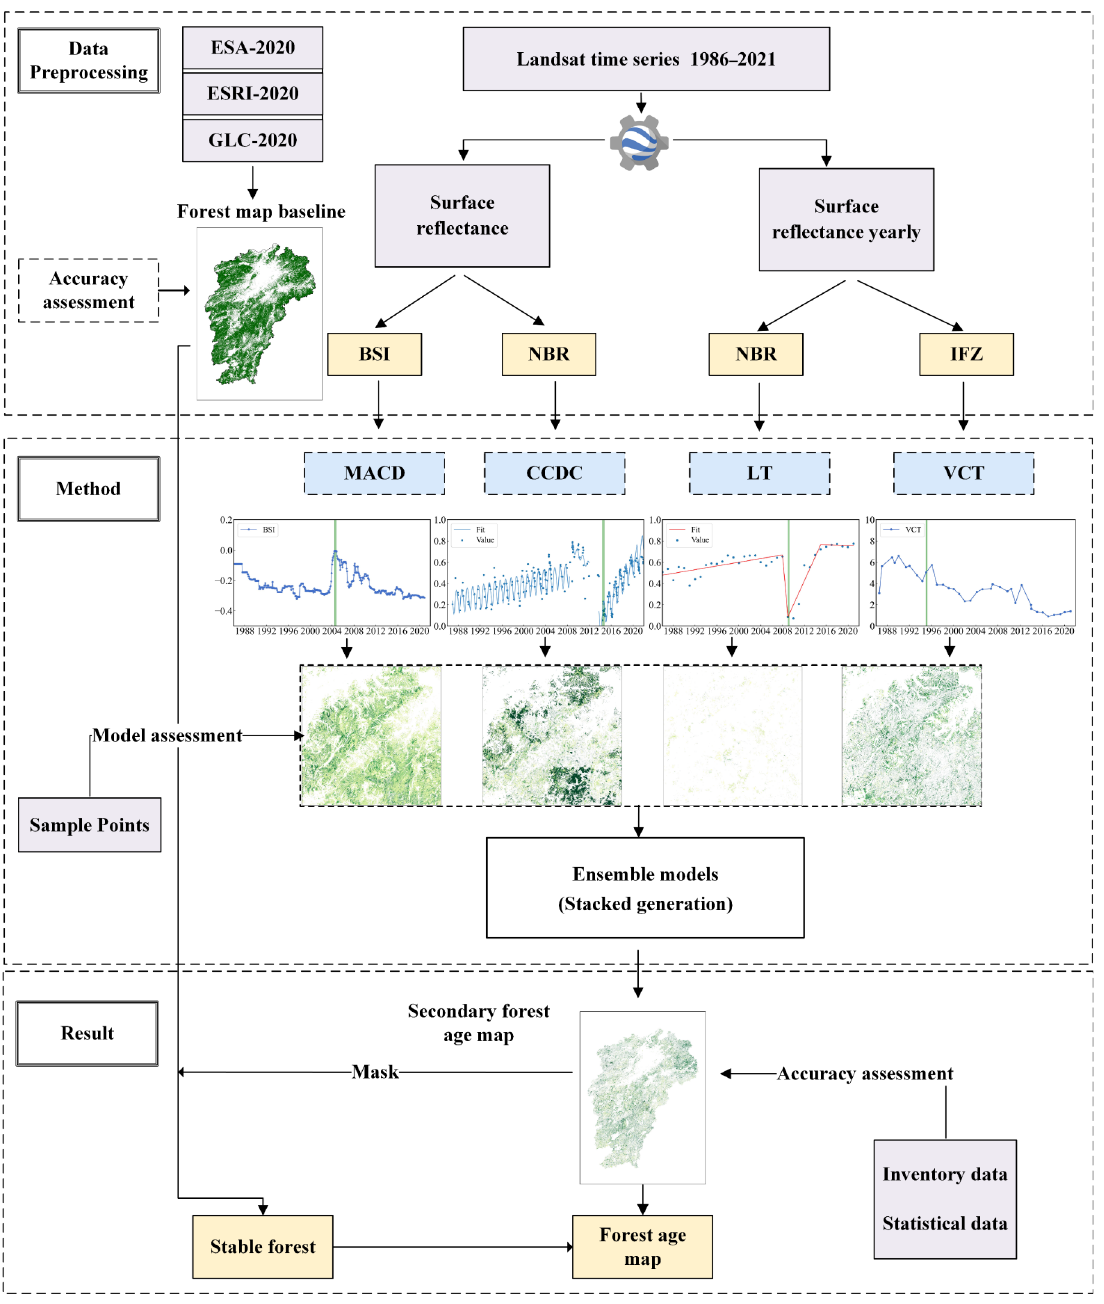
Figure 2. A flowchart illustrating the methodology used in the present study for mapping secondary forest age (SFA) in Jiangxi province. Abbreviations: World Cover 2020 (ESA-2020), ESRI 2020 Land Cover (ESRI-2020), GlobeLand 30 for 2020 (GLC-2020), bare soil index (BSI), normalized burn ratio (NBR), integrated forest Z-score (IFZ), moving average change detection (MACD), Continuous Change Detection and Classification (CCDC), LandTrendr (LT), Vegetation Change Tracker (VCT). 2.3.1. Detecting Forest Regrowth Time Using Time-Series Change Detection Algorithms Four time-series change detection algorithms were used to detect forest regrowth time, including moving average change detection (MACD), Continuous Change Detection and Classification (CCDC), LandTrendr (LT), and Vegetation Change Tracker (VCT). The latest changes were assumed to be forest regrowth. These algorithms were chosen in the present study due to their wide use in previous studies relating to SFA [22,44,45,59]. 1. Moving average change detection (MACD) is a thresholding method in which changes are defined as large deviations from the set threshold. In the present study, MACD considered the moving averages of multiple observations (often three times or more), using all Landsat data (high frequency) to remove abnormal observations by averaging adjacent observations. MACD uses the bare soil index (BSI) [45]. The